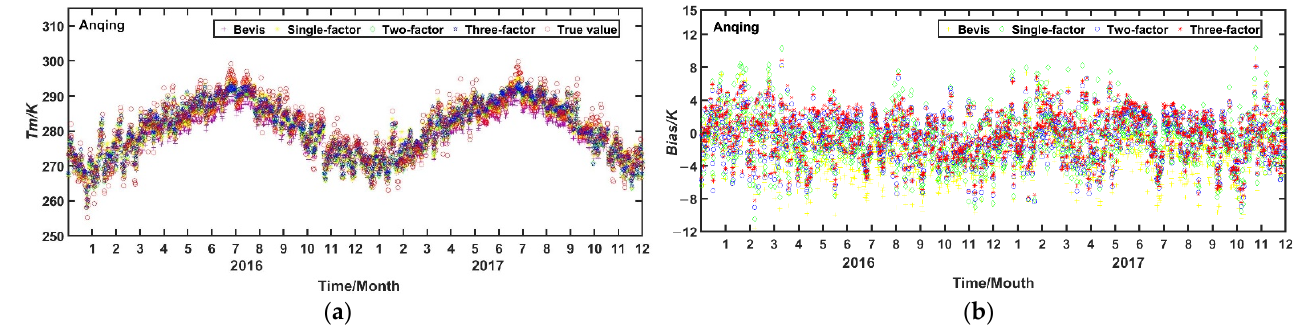
Figure 4. Comparison of the time series of T m ( a ) and the biases ( b ) of Bevis, the one-factor, two-factor and three-factor RTMs to the radiosonde-derived T m at Anqing station during 2016–2017.